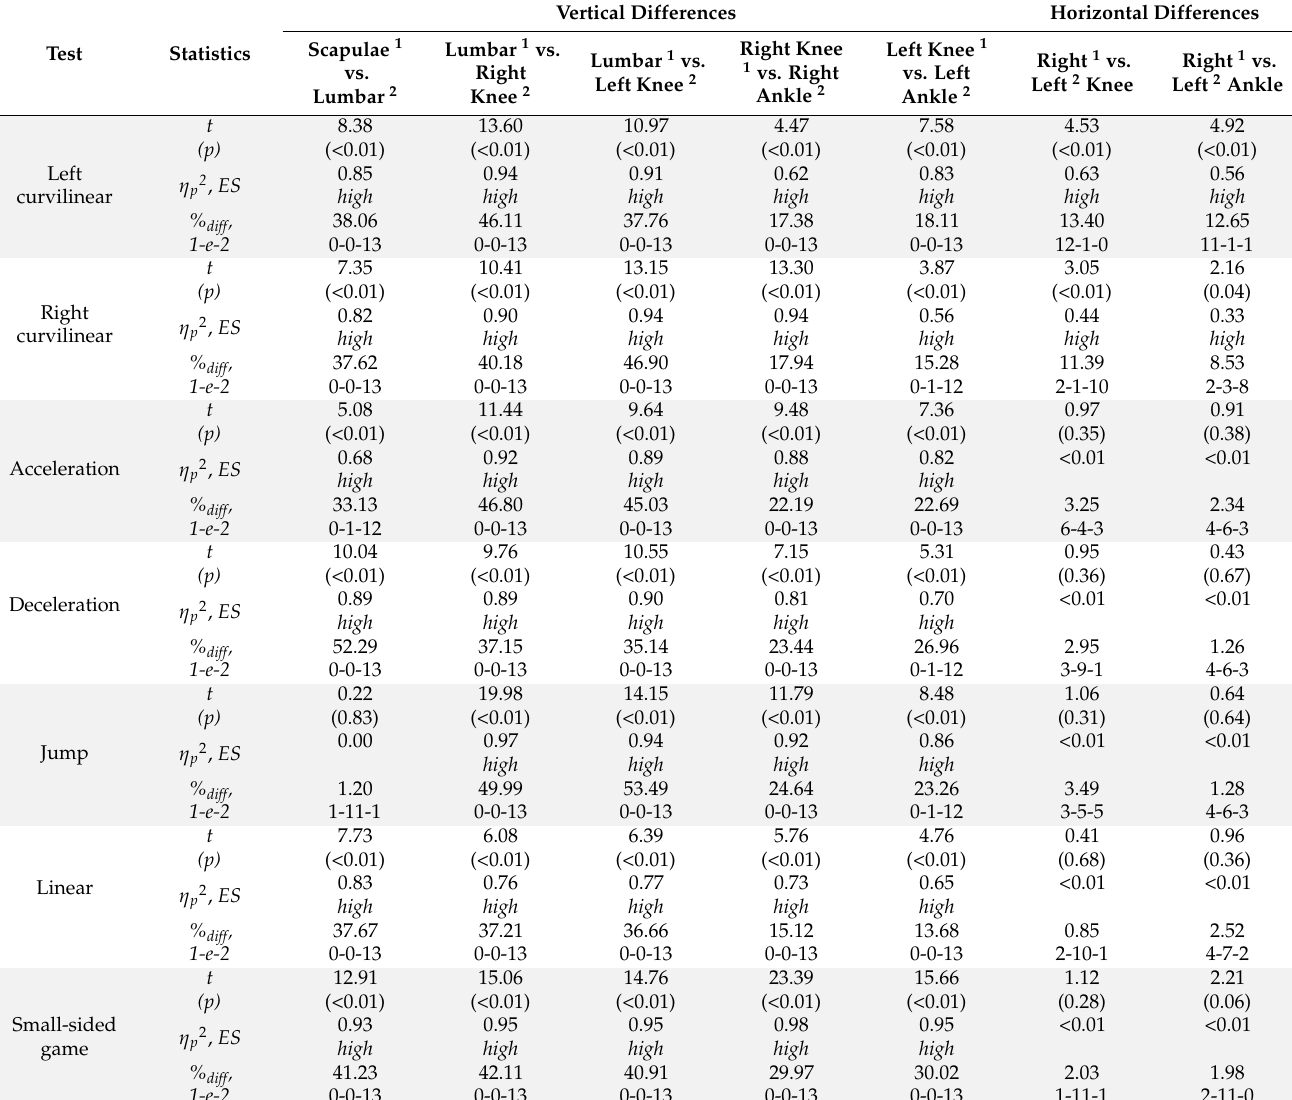
Table 2. Differences in vertical and horizontal external workload profile in the most common movements in